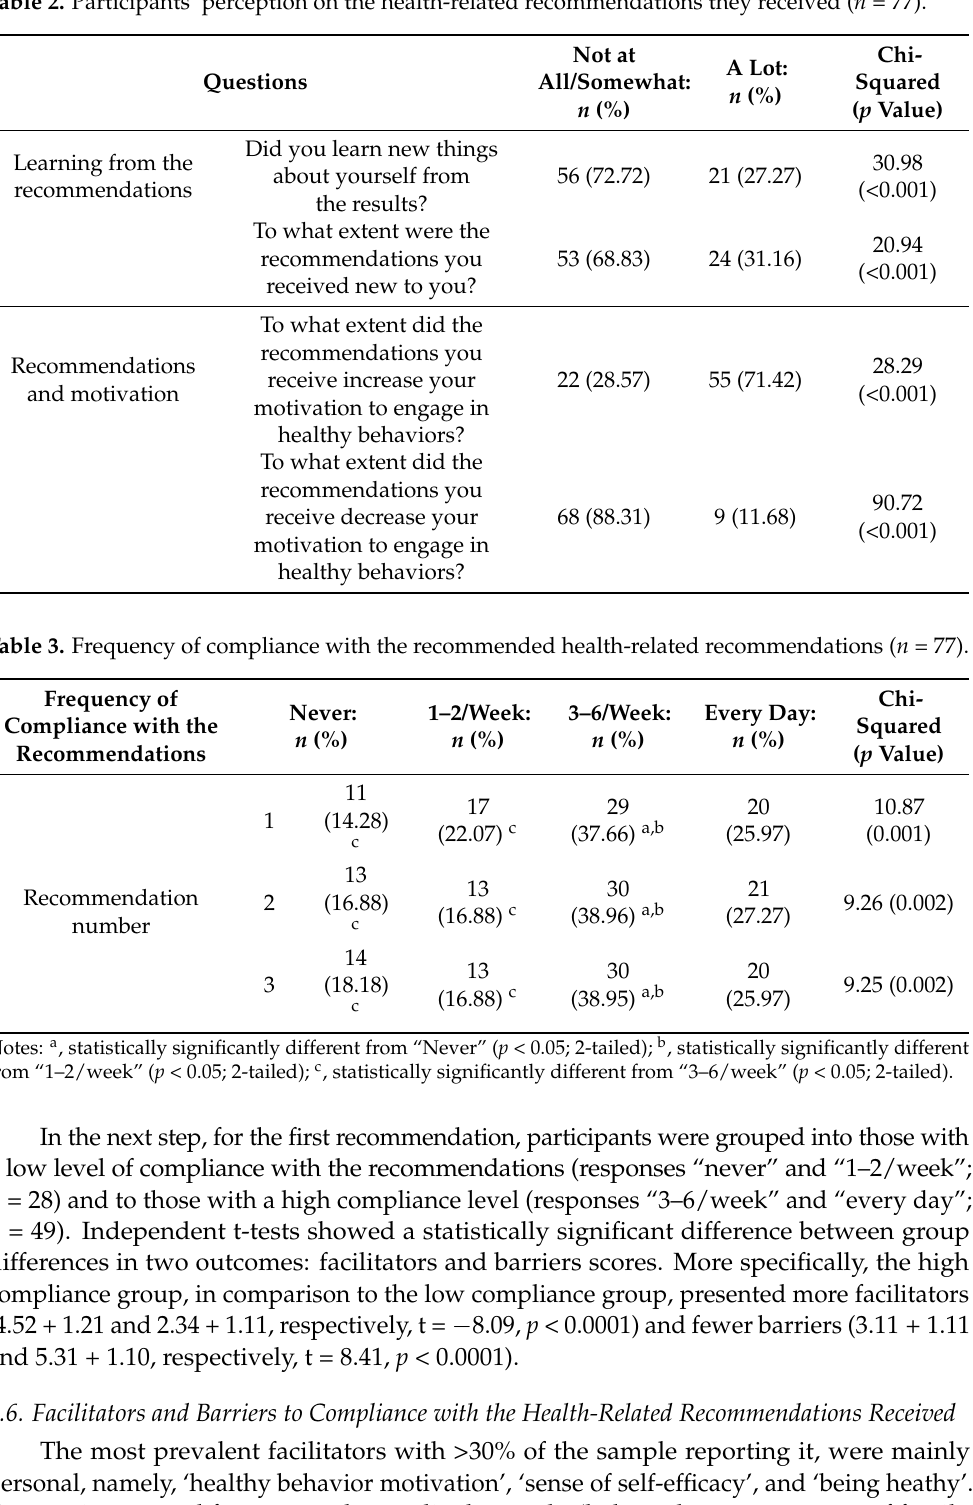
Table 2. Participants’ perception on the health-related recommendations they received ( n = 77).